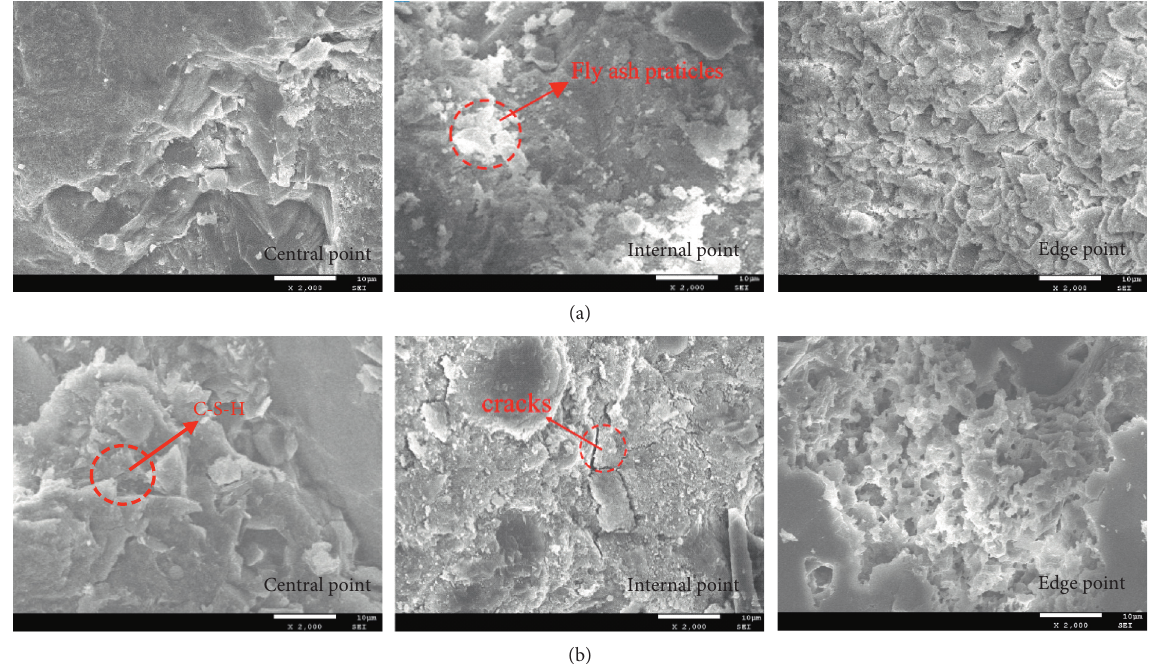
Figure 11: Electron microscope scanning of the uncorroded group. (a) 0 cycles of freeze-thaw without corrosion group. (b) 200 cycles of freeze-thaw without corrosion